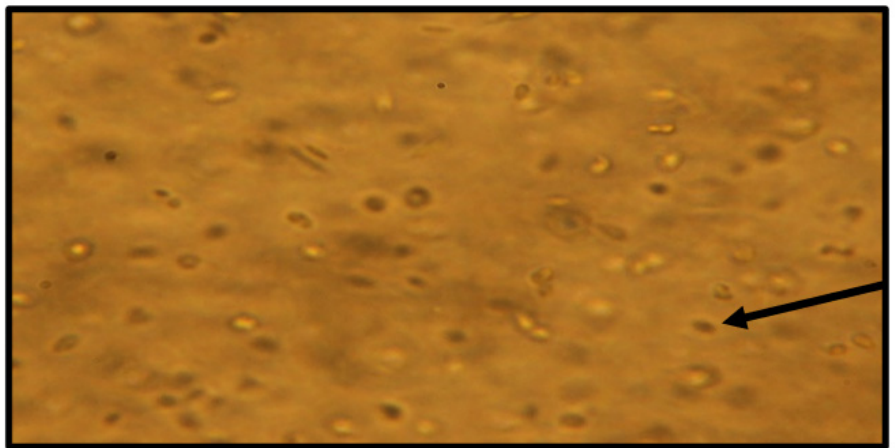
Figure 10. L. tarentolae treated with DMSO and no test compound (control cells) 143 h after treatment. 400 × magnification. Arrow indicates individual cells; we observed high cell abundance, elongated cells, flagella present, and normal motility.